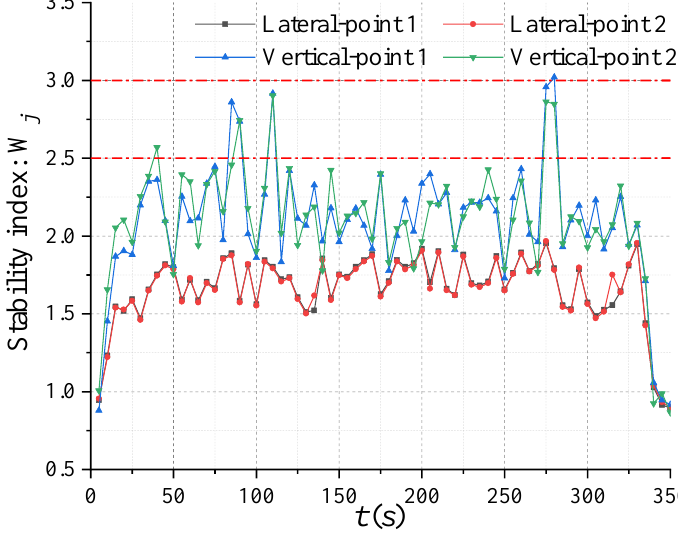
acts eccentrically on the main structure of the MTTS. The lateral stiffness of the MTTS is relatively weak, and the designers cannot ignore the lateral vibration caused by the crowd load. Therefore, this paper only studied the lateral response of human-induced vibration.